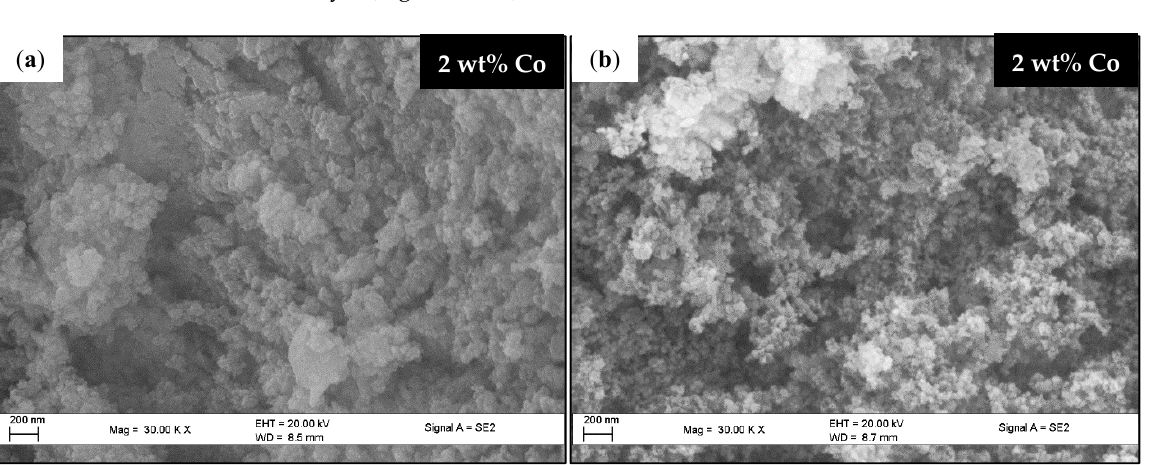
Figure 18. SEM micrographs of 6 wt% Co catalysts; ( a , b ) fresh catalyst, ( c , d ) used catalyst. 2.4.2. Energy Dispersive X-ray (EDX) SEM-EDX dot mapping images revealing the major elemental components (Co, Al and Si) on the inner surfaces—exposed to plasma—of the used 2 and 6 wt% Co catalysts, are presented in Figures 19 and 20, respectively. These images show that the cobalt parti- cles were uniformly distributed on both used catalyst surfaces, which was enhanced by plasma treatment as shown in SEM (Section 2.4.1) and TEM (Section 2.4.3) analysis. The images and intensity plots also verify that approximately three times more cobalt was present in the 6 wt% Co catalyst.